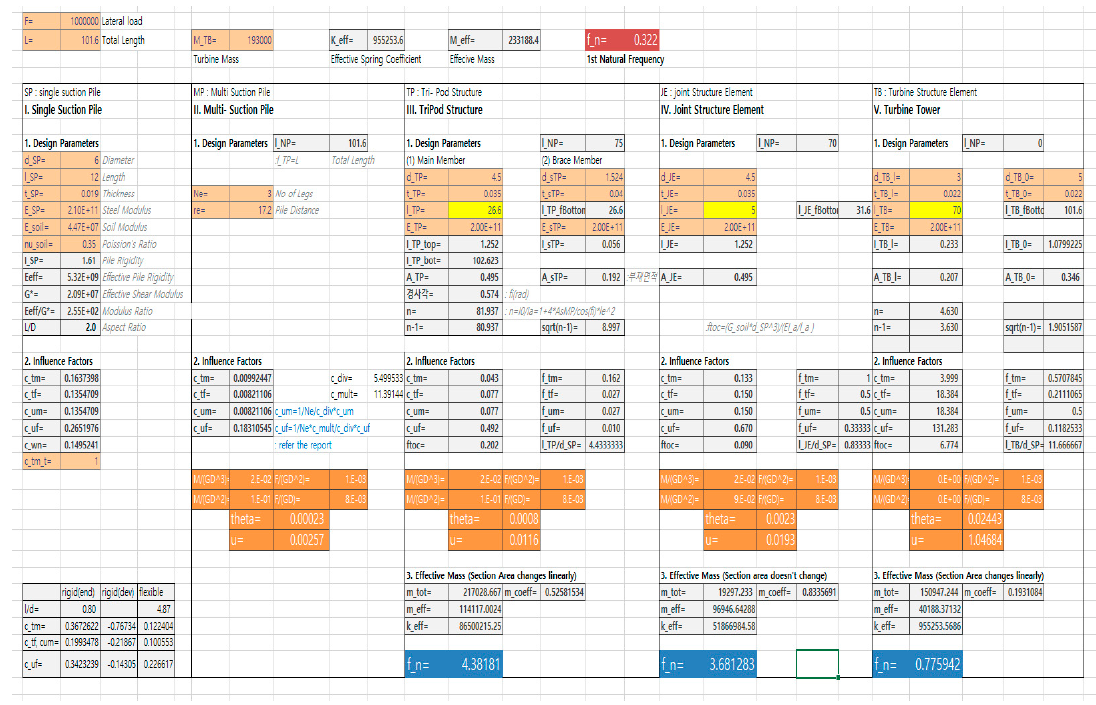
Figure 21. Simplified dynamic analysis method (MS-Excel